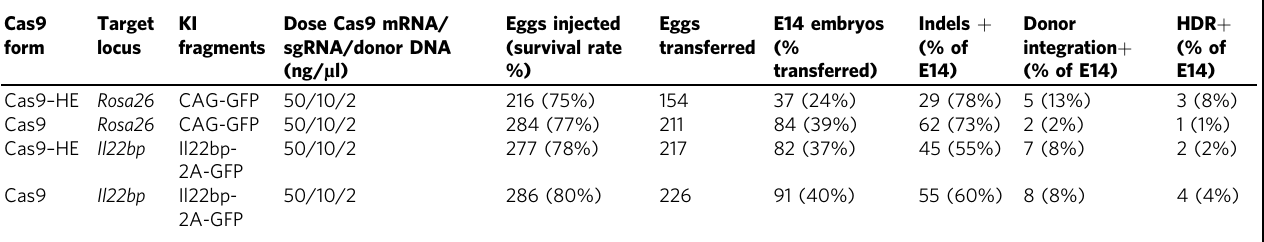
HDR + , HDR-mediated GFP transgene integration was de fi ned as positive in E14 embryos for which both 5 ′ and 3 ′ in – out PCRs were detected using primers in the transgene and outside the homology arms (with PCR products con fi rmed by DNA sequencing, schematic of PCR primer positions in Supplementary Fig. 5); indels + , E14 embryos in which indels were detected by sequencing of PCR amplicons from the targeted genomic region; donor integration, E14 embryos in which PCR ampli fi cation of the transgene was